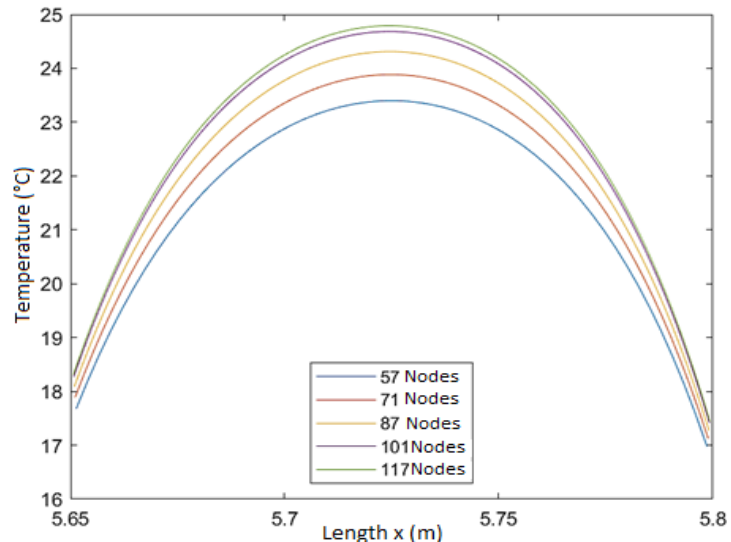
Figure 4. Distribution of temperatures at the outlet of the GAHE according to the number of nodes in the diameter of the outlet pipe.